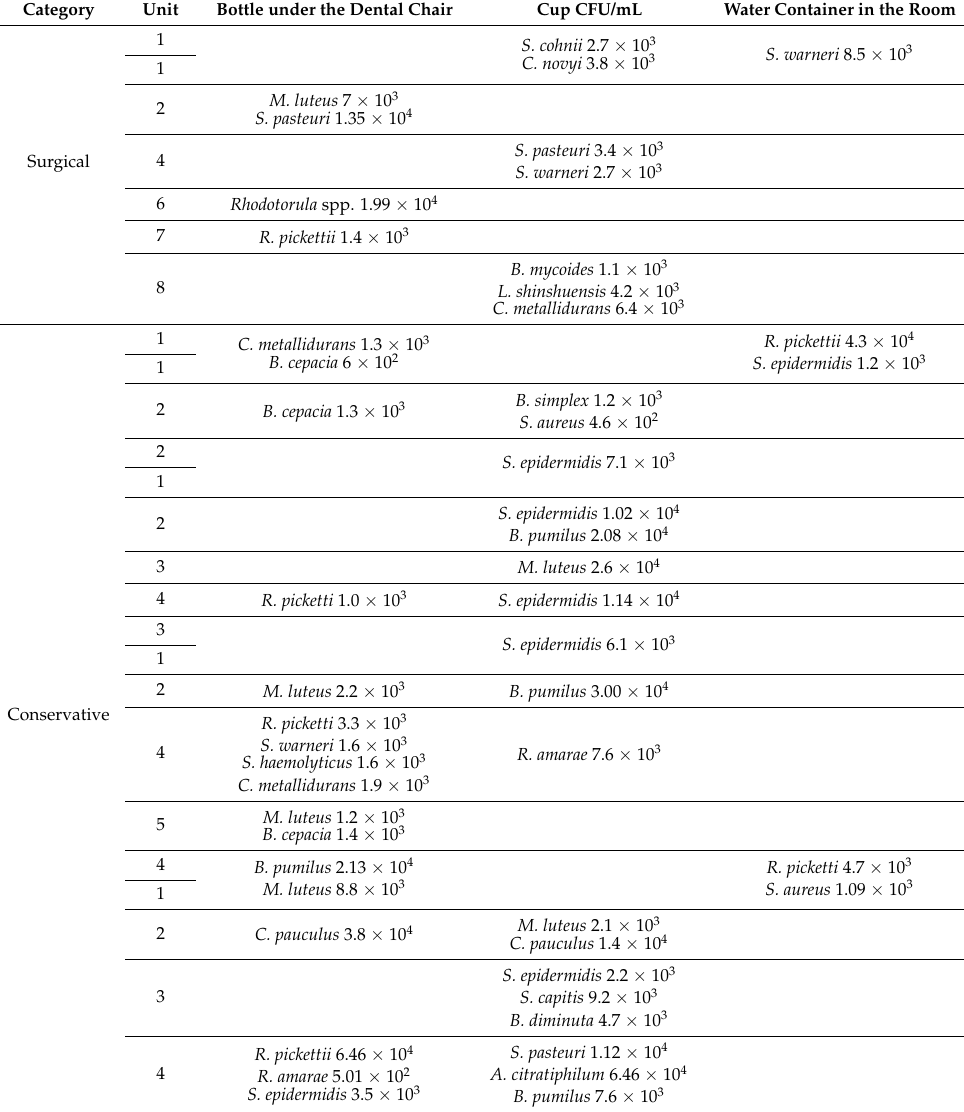
Table 2. Microorganisms exceeding the limit value of CFU/mL in dental units. Category